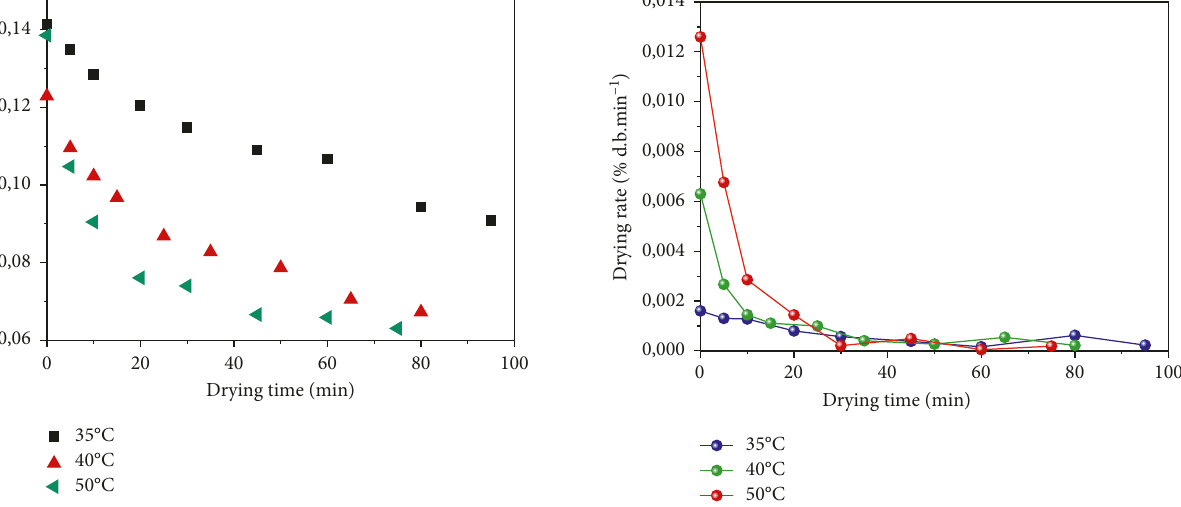
Figure 3: Evolution of drying rate versus time for different drying air temperatures of Crocus sativus L.